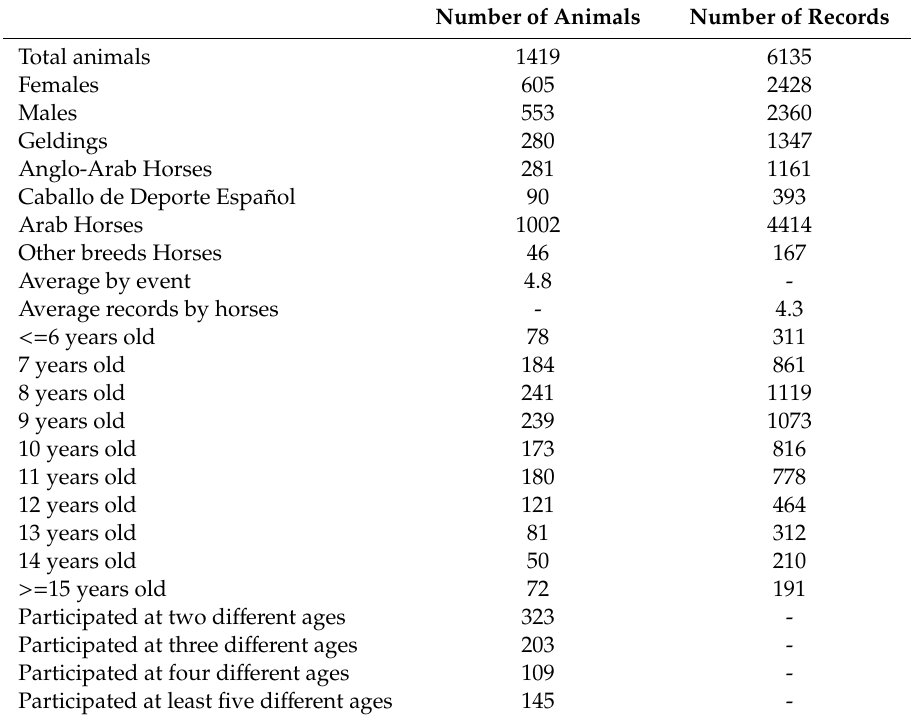
Table 1. Structure by systematic e ff ect and number of records of endurance races included in the